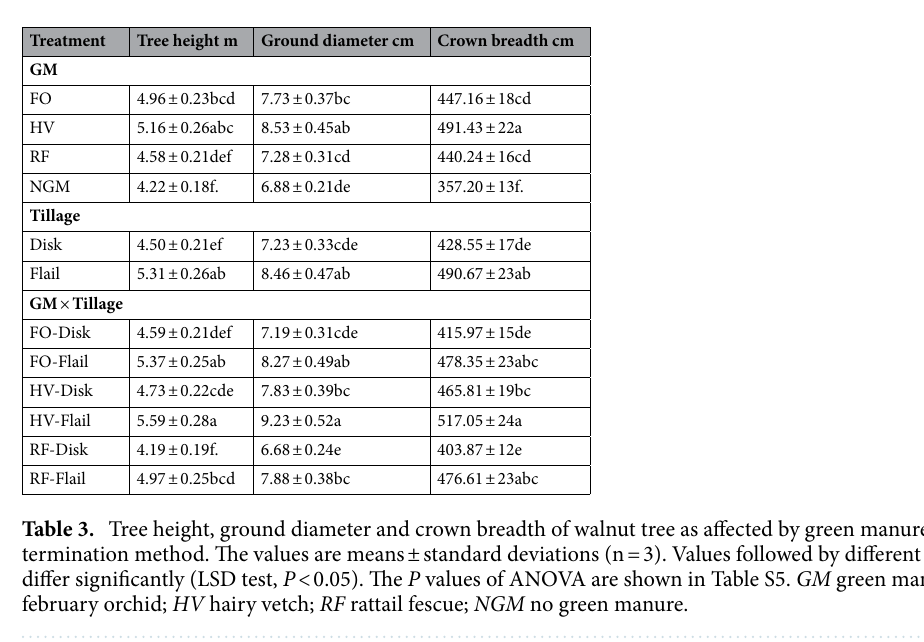
ferences were observed in the tree height or ground diameter between the rattail fescue and no-green-manure treatments (Table 3) ( P > 0.05). Crown breadth was significantly higher under the green-manure treatment, with the February orchid, hairy vetch, and rattail fescue treatments being 25.2%, 37.6% and 23.2% higher than the no- green-manure treatment, respectively (Table 3) ( P < 0.05). The tree height, ground diameter and crown breadth were also affected by the termination method. The tree growth was significantly greater under flail relative to disk with tree height, ground diameter and crown breadth having 17.0%, 18.0% and 14.5% higher values (Table 3) ( P < 0.05). Table 4 showed that compared with the walnut trees in the no-green-manure treatment, the trees in the green manure treatments were found to have an increasing trend in root length, root length density and root surface area. Root length under the February orchid, hairy vetch, and rattail fescue treatments was 1453, 1477 and 1357 cm respectively, being 1.05 times, 1.04 times and 1.01 times the length of no-green-manure treatment.